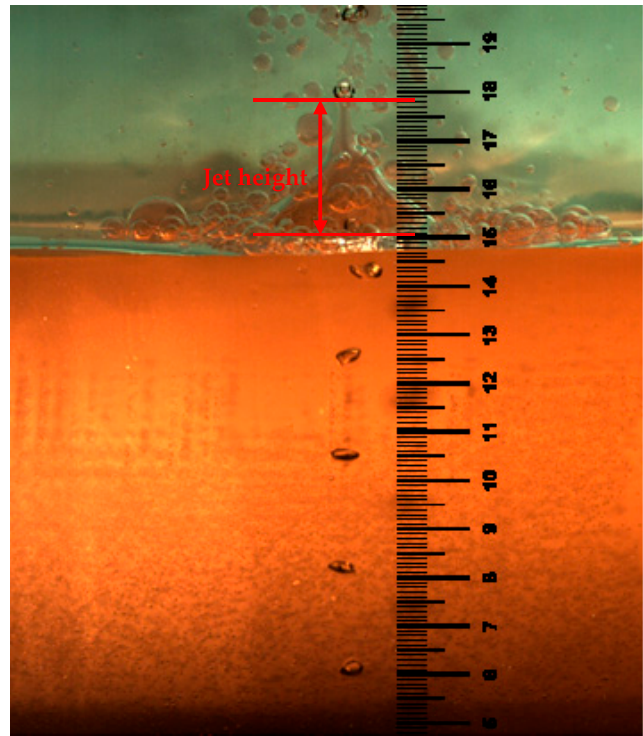
Figure 9. Measuring method of water–oil interface jet height.